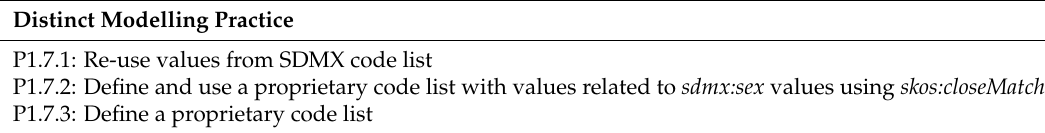
Table 17. Distinct modelling practices of data portals for populating the gender